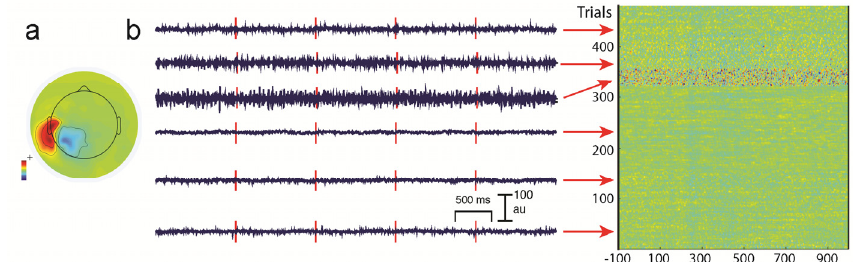
Figure 5. The varying nature of muscle activity. ( a ) Topography of muscle artifact, as identified with an independent component analysis (ICA) map from EEG data. The color scale depicts arbitrary units. ( b ) Six ICA time courses showing electromyographic (EMG) activity from five epoched single trials (red vertical lines) that waxes and wanes during the course of an experiment (bottom to top: increasing time during the experiment). a.u. = arbitrary units. Maximum EMG activity is seen in the third trace from the top. At the right, a compressed display of ICA time courses across the entire experiment (colors depict arbitrary units) of a total of nearly 500 trials is shown. The red arrows identify time points during the experiment to which the time courses correspond. The display also shows a period of pronounced EMG activity from around trials 325–330 at which the EMG activity was maximal, as also shown by the third time course at left.